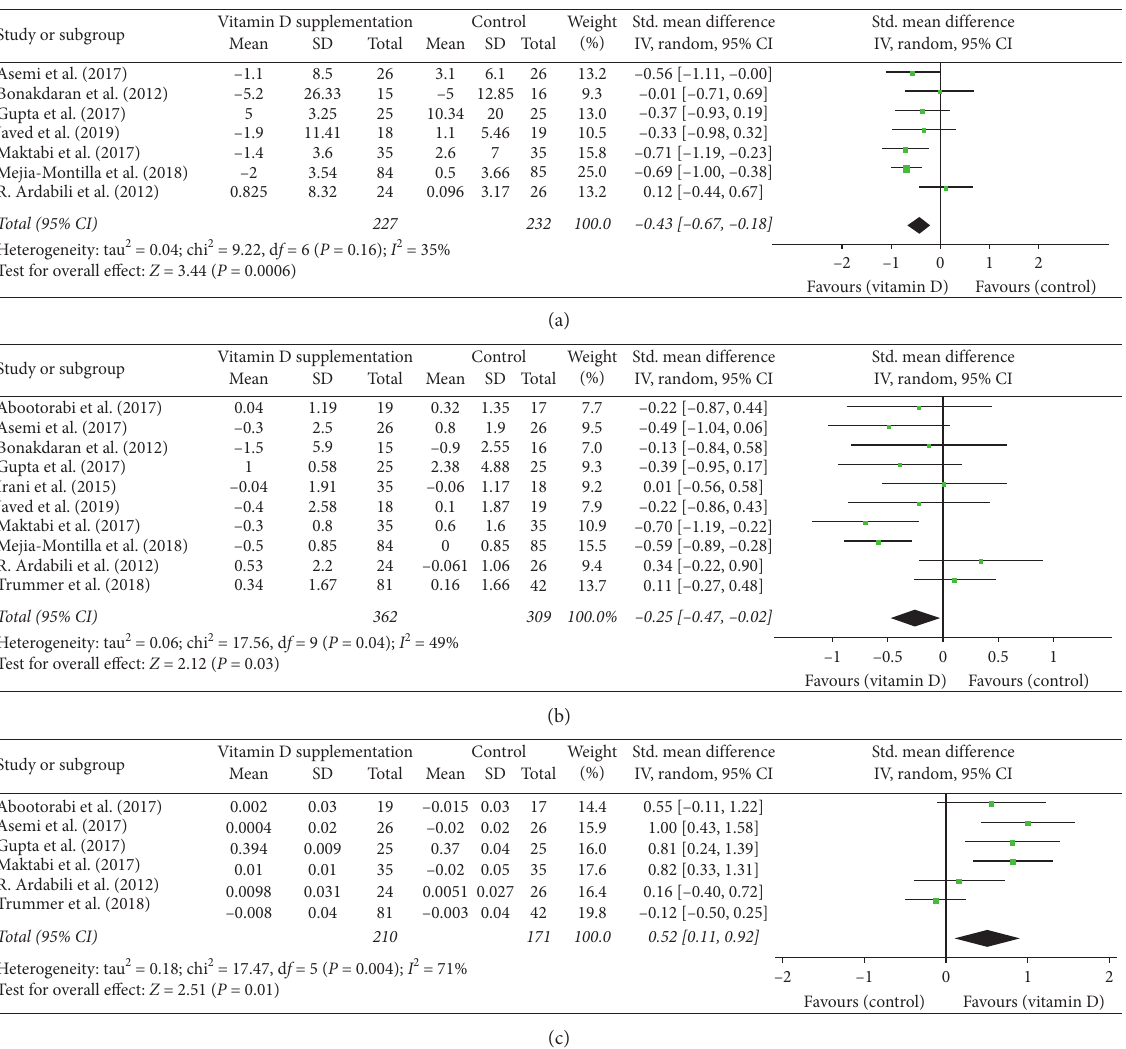
Figure 5: (a) Forest plot of fasting insulin level in experimental and placebo groups. (b) Forest plot of HOMA-IR in experimental and placebo groups. (c) Forest plot of QUICKI in experimental and placebo